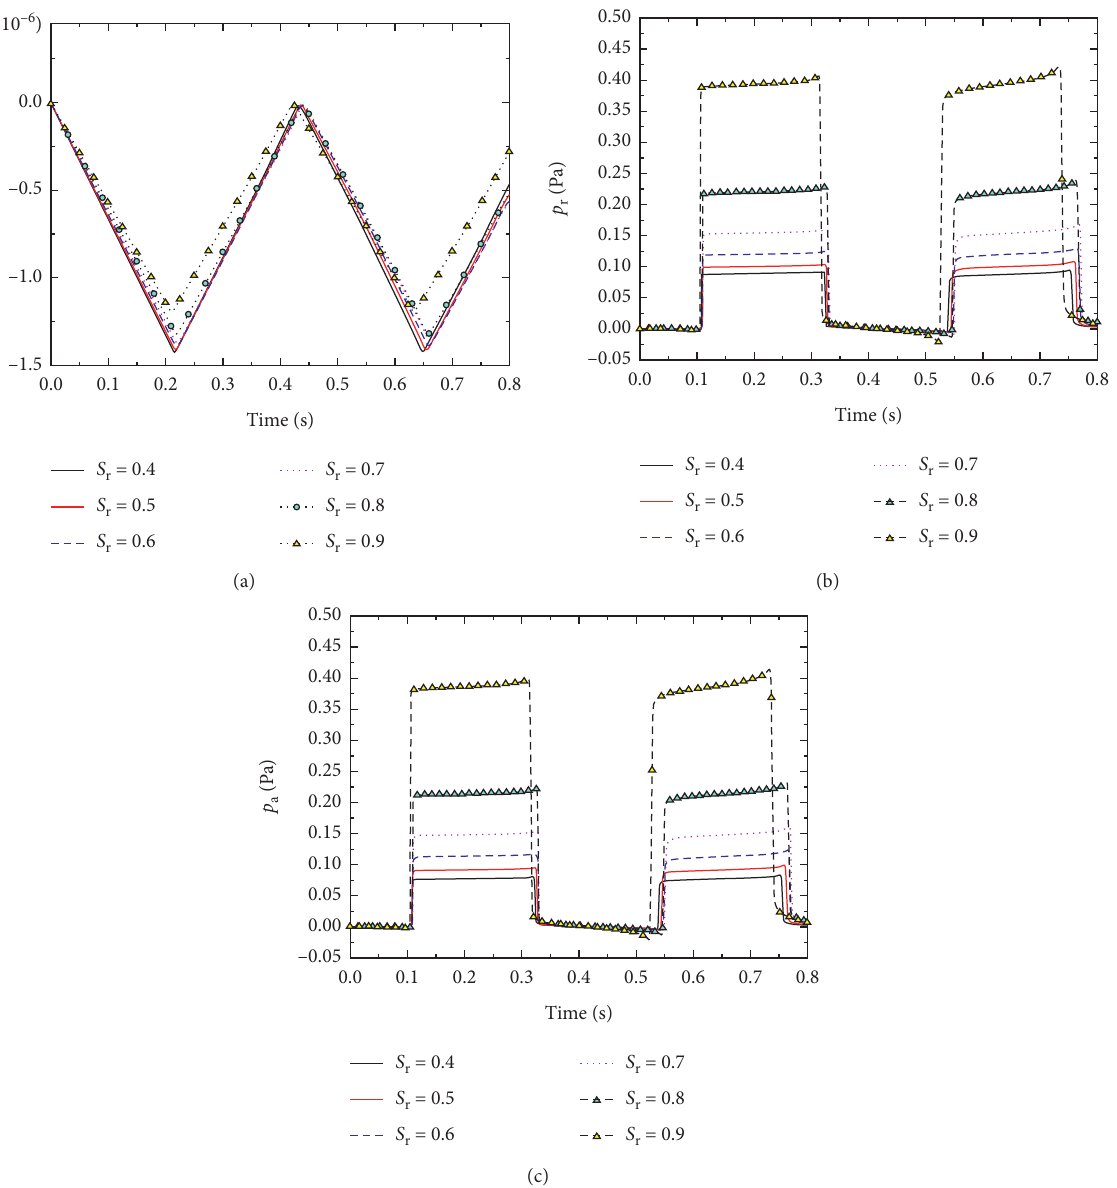
Figure 4: Distributions of the displacement of solid particles u using different fluid saturation values ( S r � 0.4 to 0.9). (a) u z . (b) p f . (c) p a